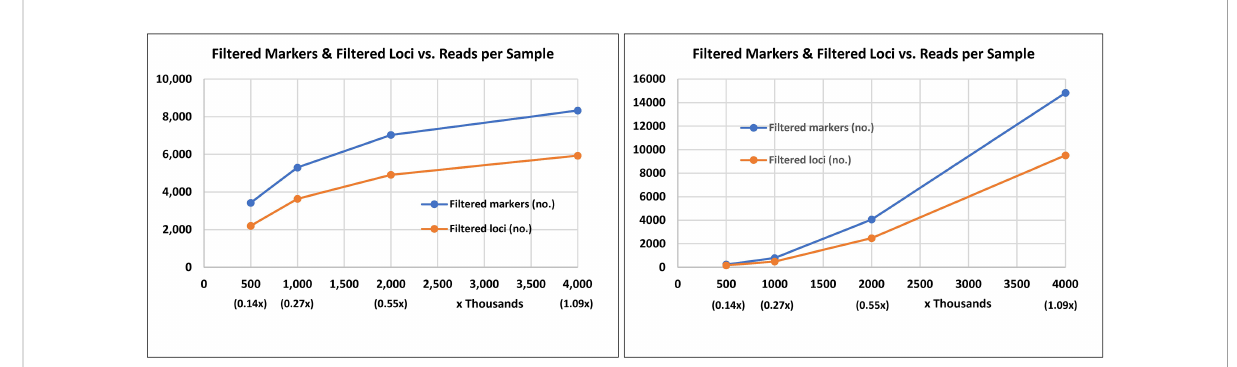
FIGURE 1 Marker and locus discovery rate from genotyping by sequence after digestion of Gerbera genomic DNA with two combinations of restriction enzymes and sequencing at different read depths (number of reads per sample). The combination of Bam HI and Nsi was used in the left chart and the combination of Btg I and Taq I in the right chart. Genomic DNA digestion, sequencing library preparation, and genotyping by sequencing were completed at the University of Minnesota Genomics